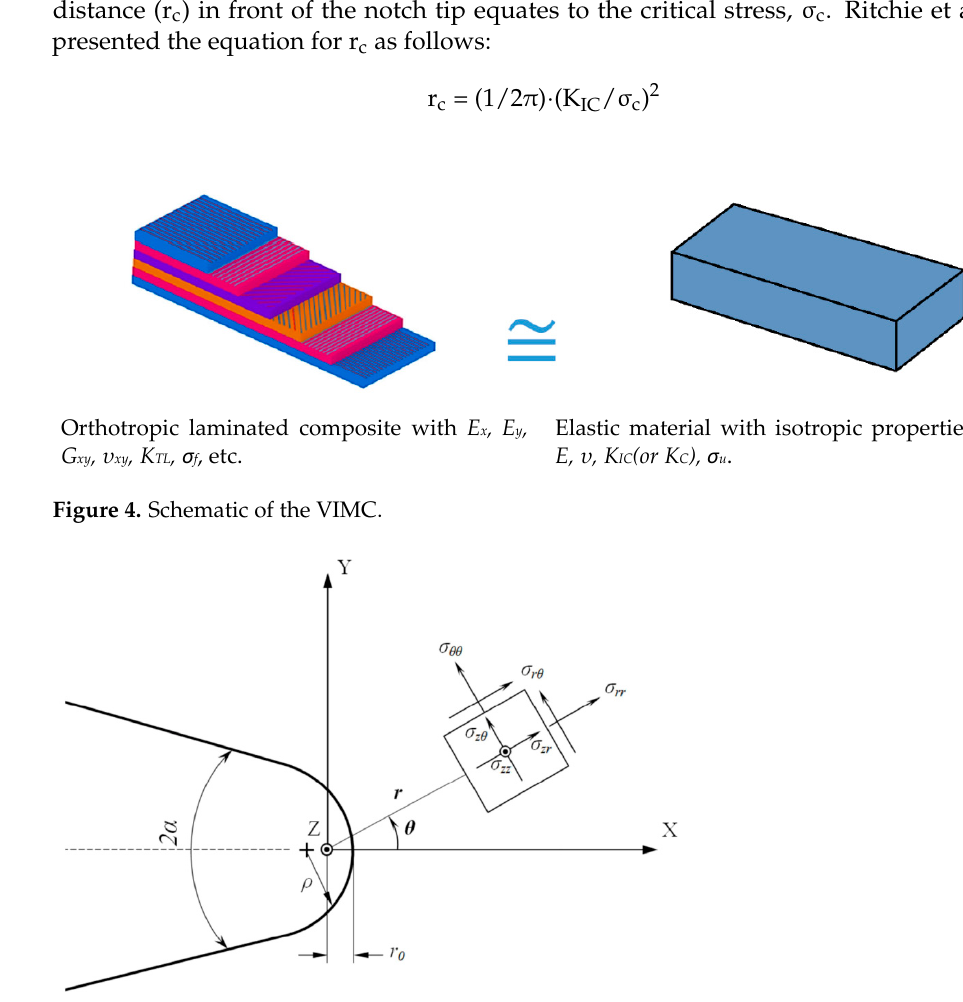
Figure 5. Blunt V-notch with its coordinate system and the resulting geometrical